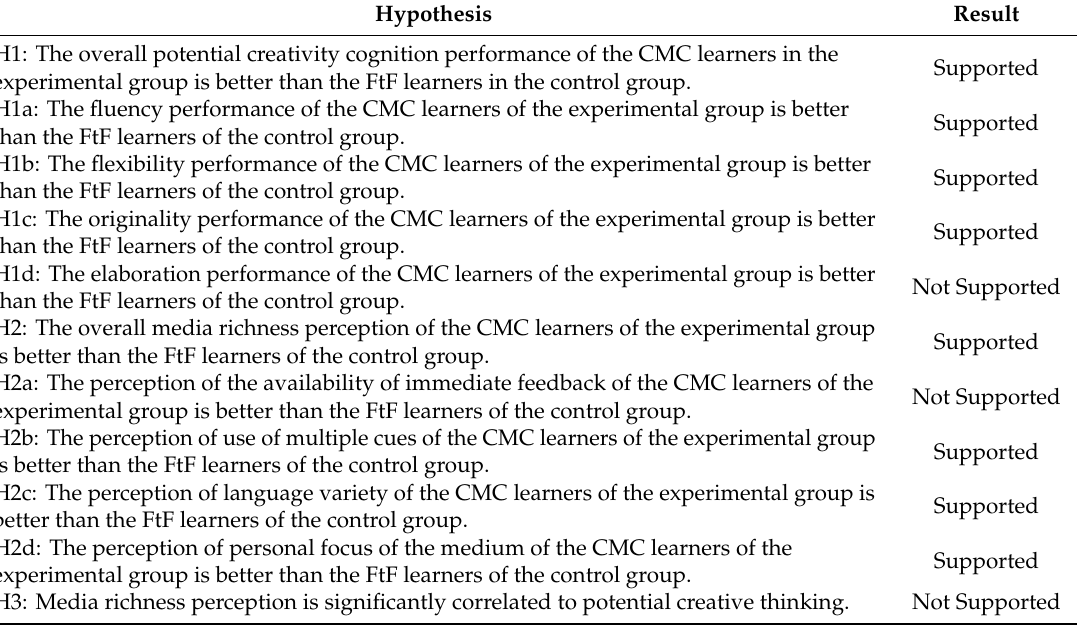
Table 12. Research hypothesis